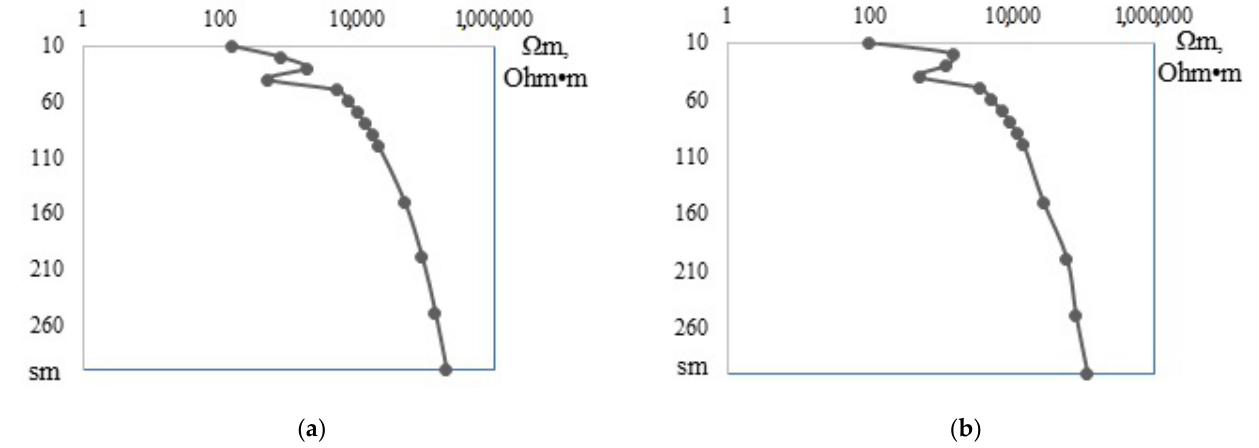
Figure 4. Electrical resistivity (ER, Ωm) of burned and control soil profiles: ( a ) postfire plot; ( b ) control plot.